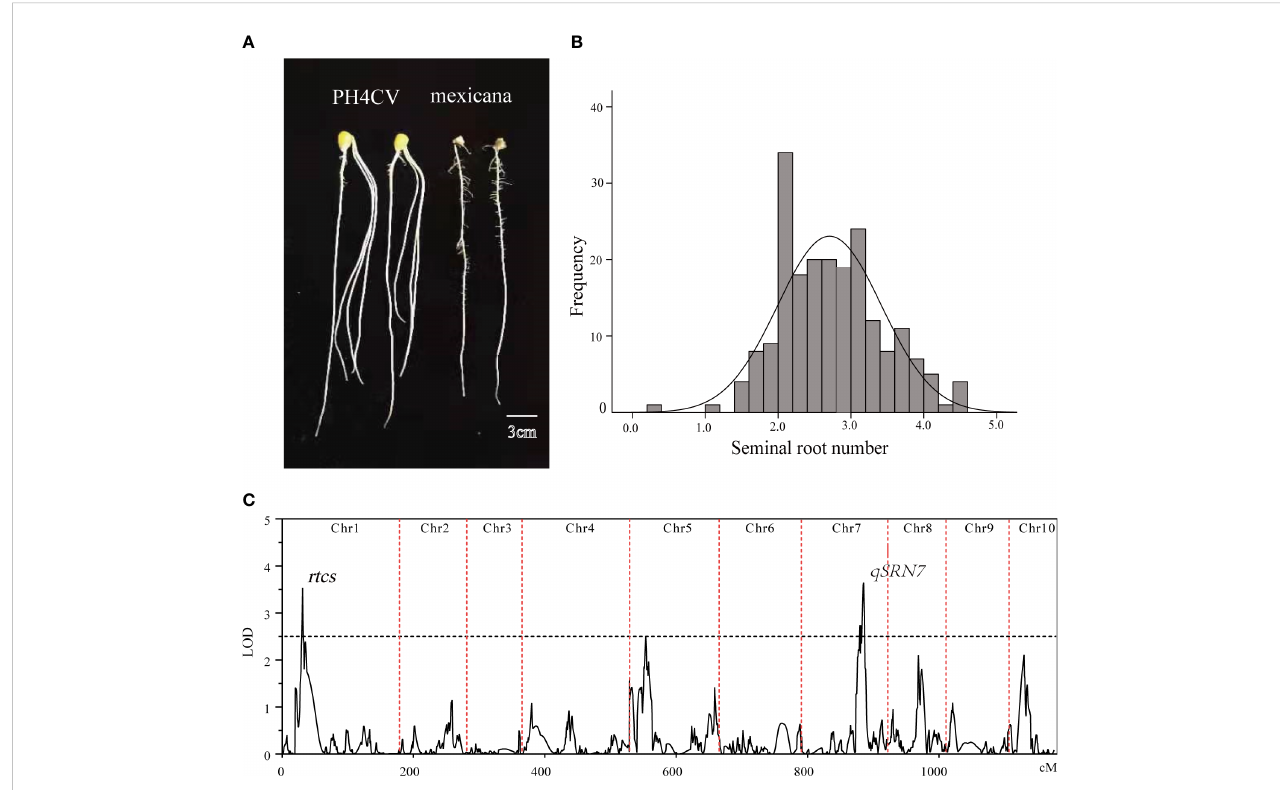
FIGURE 2 QTL mapping of SRN. (A) SRN in PH4CV and teosinte. (B) Frequency distribution of SRN in the TP population. (C) QTLs detected for SRN in the TP